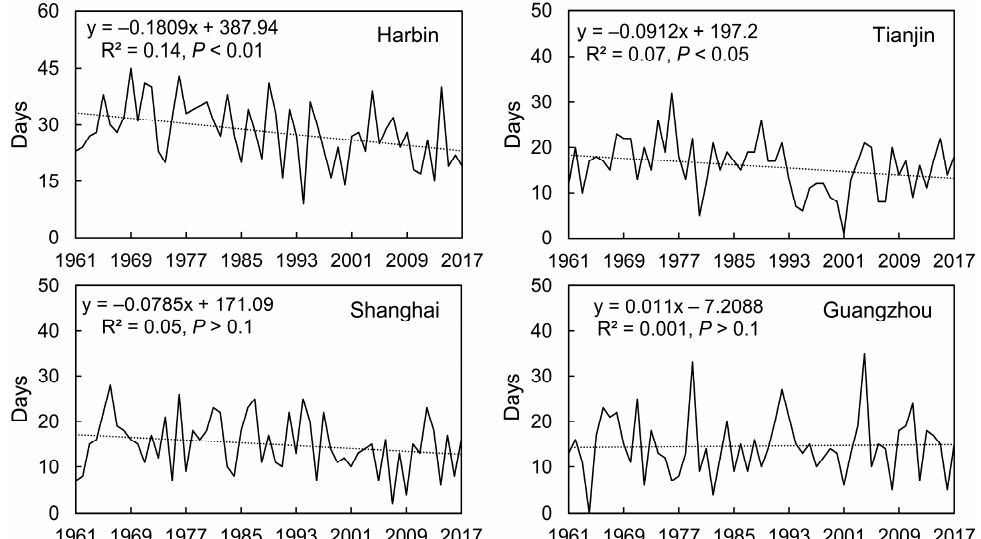
Figure 5. Changes in degree days with no cooling and no dehumidi fi cation during the period of 1961–2017 for the four selected